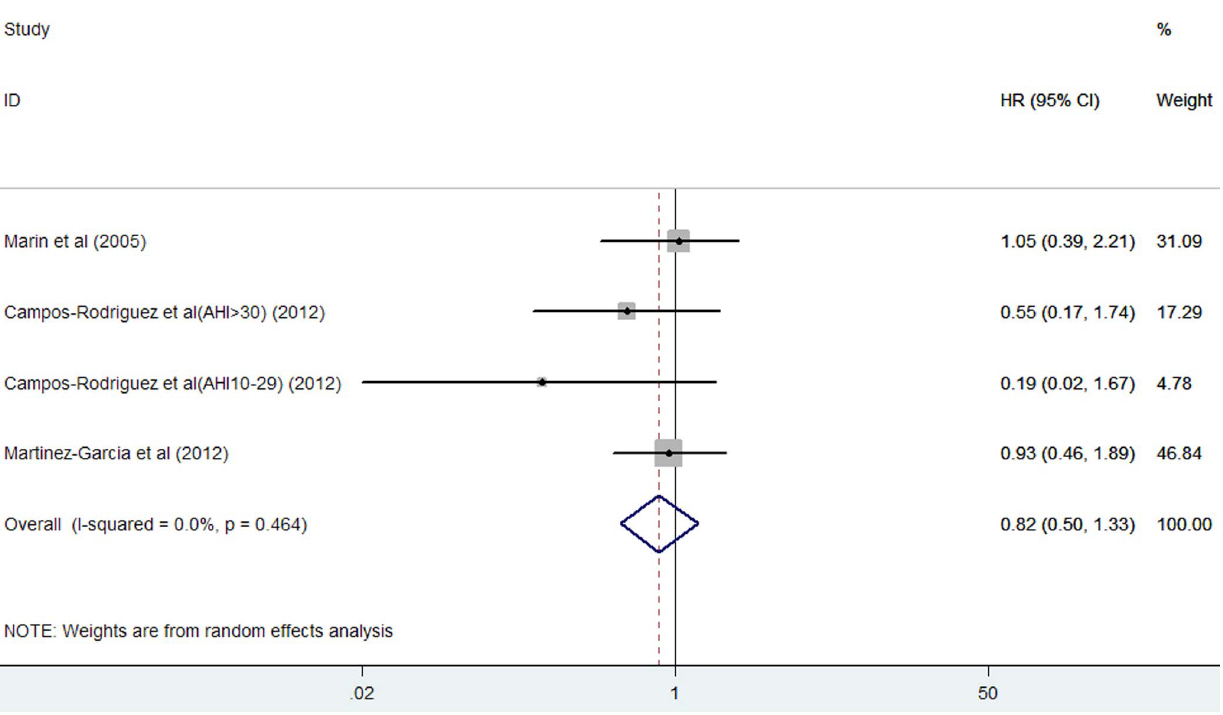
Figure 4. HR and 95% CI from the included studies of continuous positive airway pressure treatment with cardiovascular mortality comparing OSA to the control.